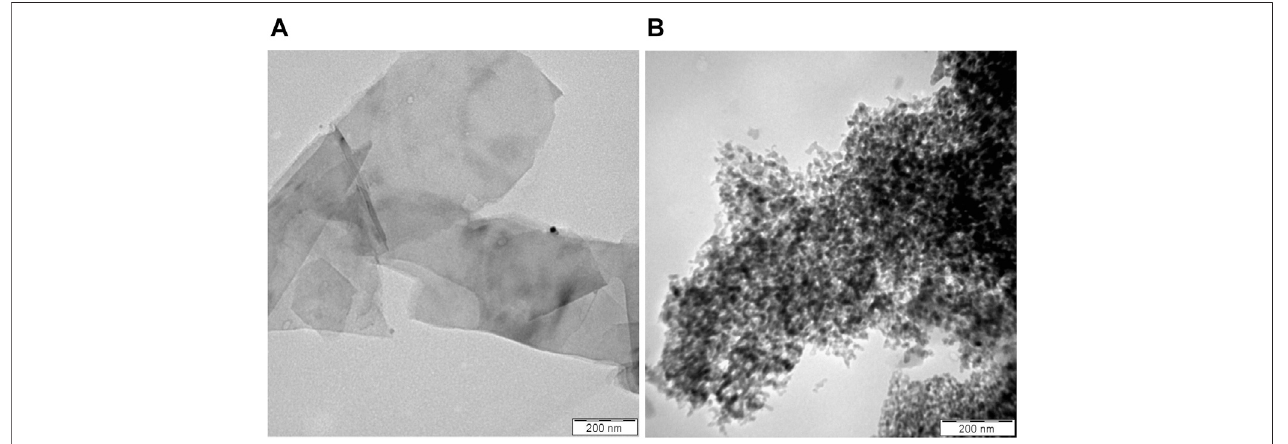
FIGURE 2 | TEM images of the nano fl uids with (A) mono-GNP, and (B) hybrid GNP-alumina.